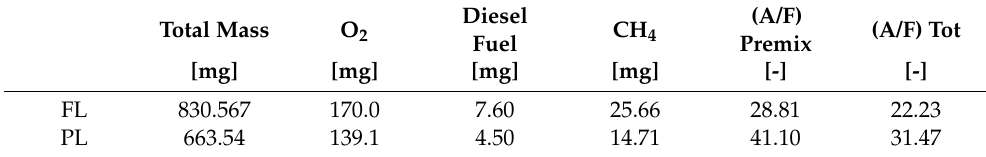
Figure 5. Computational grids of the tested bowls .